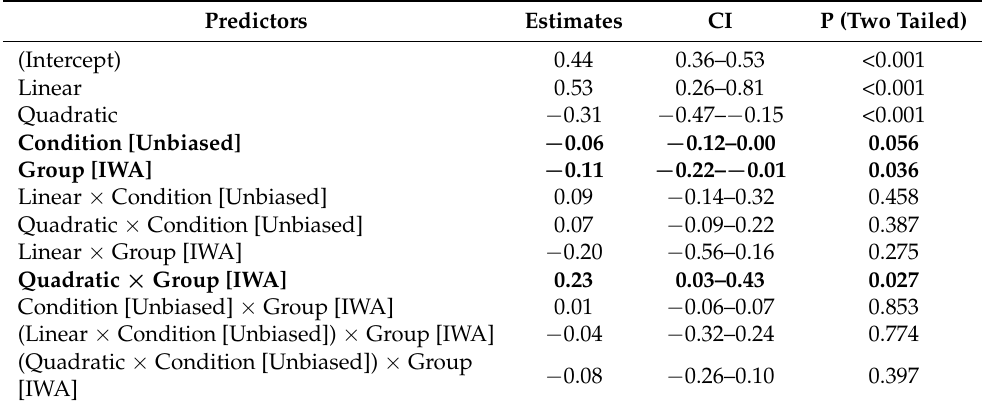
Table A2. Results of GCA analysis for time window